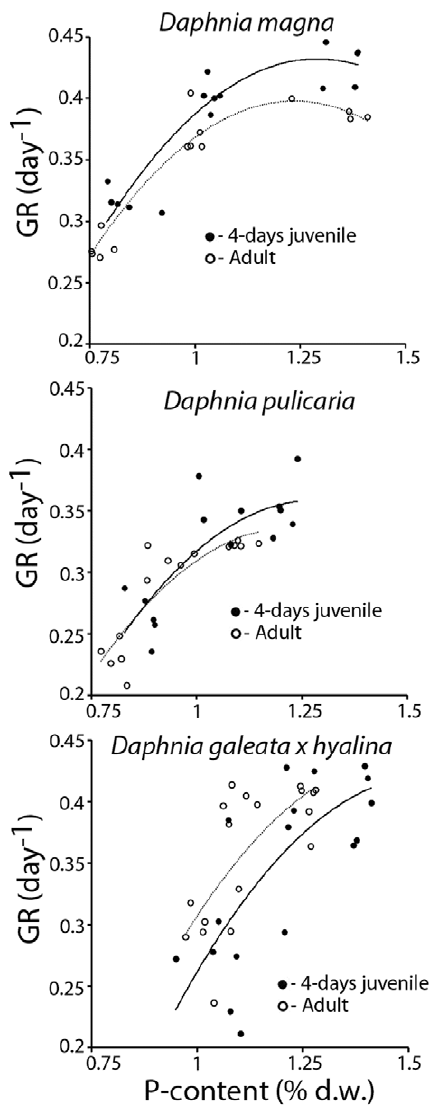
Figure 1. Mass-specific P-content in relation to specific growth rates of D.magna , D.pulicaria and D.galeataxhyalina , after four days (closed symbols) and at maturation (open symbols). Lines were fitted using ANCOVA with quadratic term for P-content.